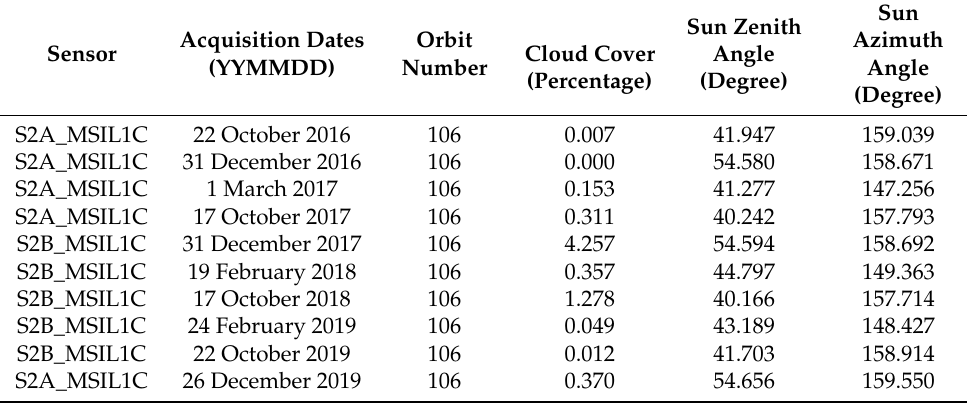
Table 1. The specific information of collected Sentinel-2A/B